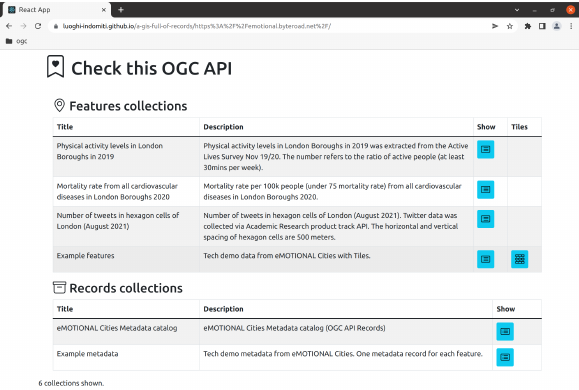
Figure 9. The metadata browser prototype implemented for eMOTIONAL Cities